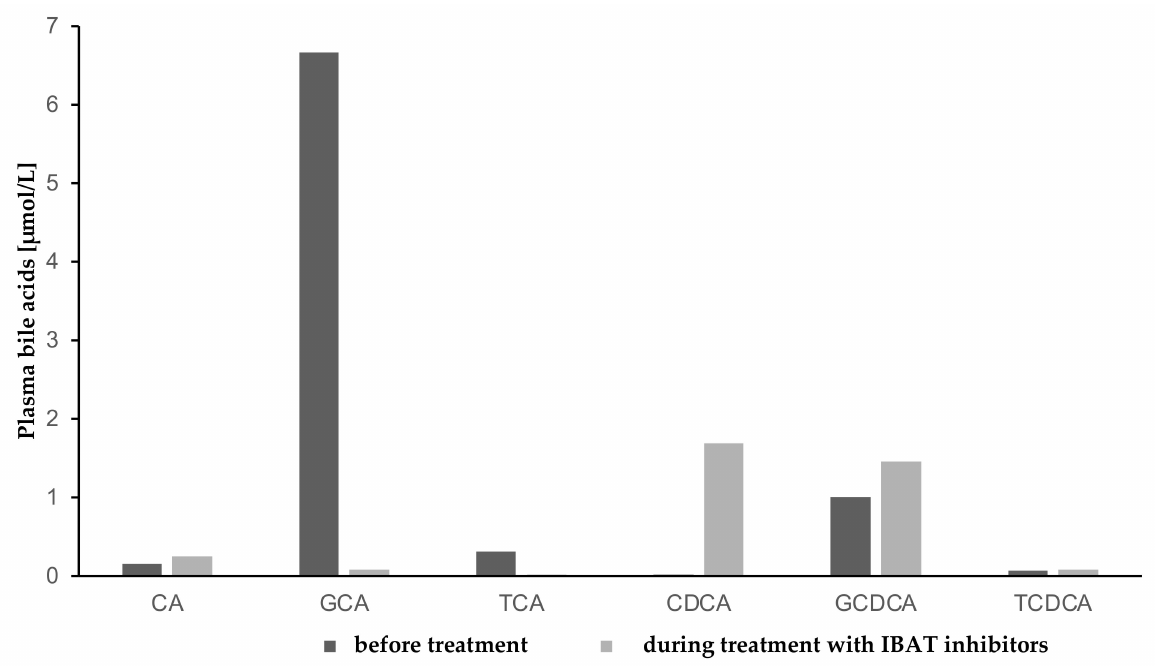
Figure 5. Primary bile acids and their conjugates in plasma before and during treatment with IBAT inhibitors. CA, Chenodeoxycholic acid; GCA, Glycocholic acid; TCA, Taurocholic acid; CDCA, Chenodeoxycholic acid; GCDCA, Glycochenodeoxycholic acid; TCDCA, Taurochenodeoxycholic acid, IBAT, ileal bile acid transporter inhibitor.